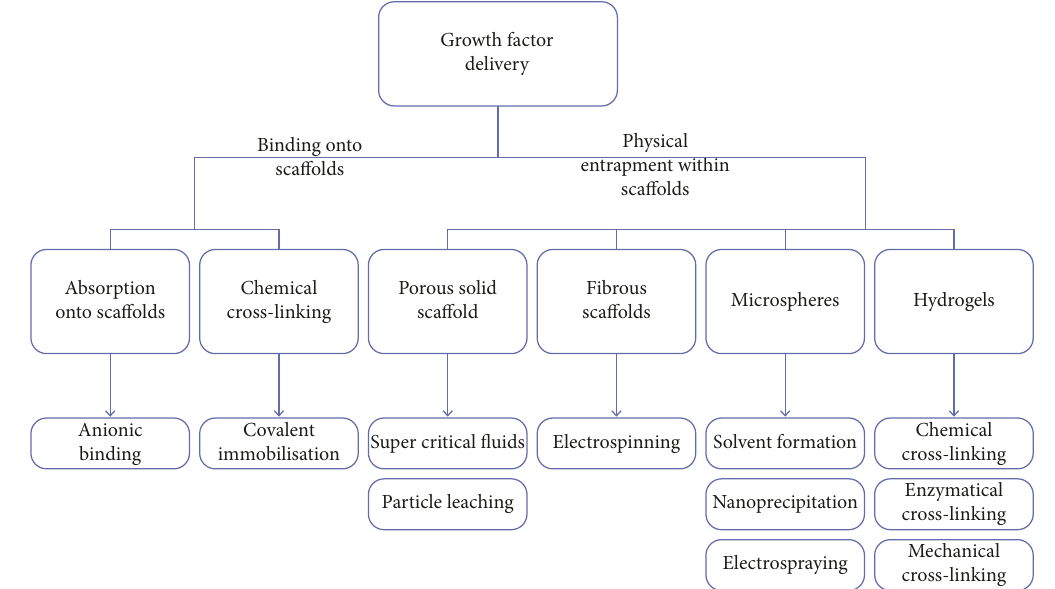
Figure 2: Current methods for fabrication of growth factor-loaded scaffolds